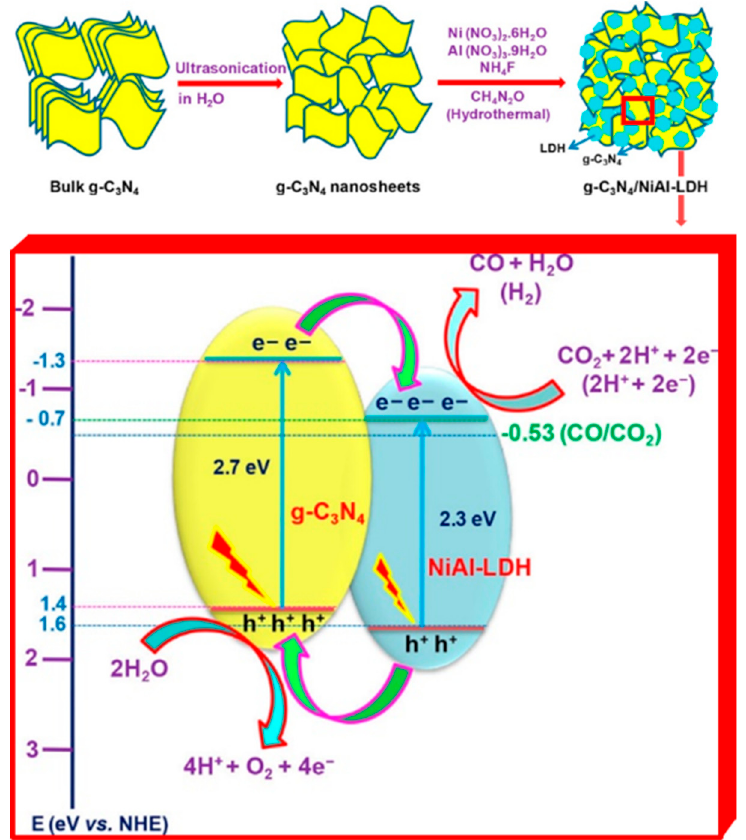
Figure 9. Top. Schematic illustration of the synthesis process of g ‐ C 3 N 4 /NiAl ‐ LDH hybrid heterojunctions. Bottom. Proposed mechanism for CO 2 photoreduction in the g ‐ C 3 N 4 /NiAl ‐ LDH heterojunctions. Adapted from Reference [152]. Copyright 2018 American Chemical Society.